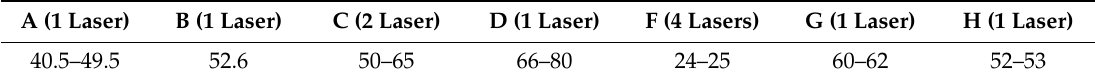
Figure 28. Rockwell hardness C (HRC) values across the selected companies: XY face ( left ); XZ face ( right ).